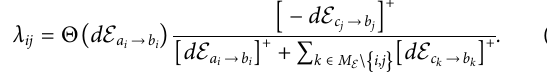
(cid:2) [− d E ] + / ([ d E ] + + [ d E ] + ) . Note that this can be extended to match Eq. 20 green green red blue